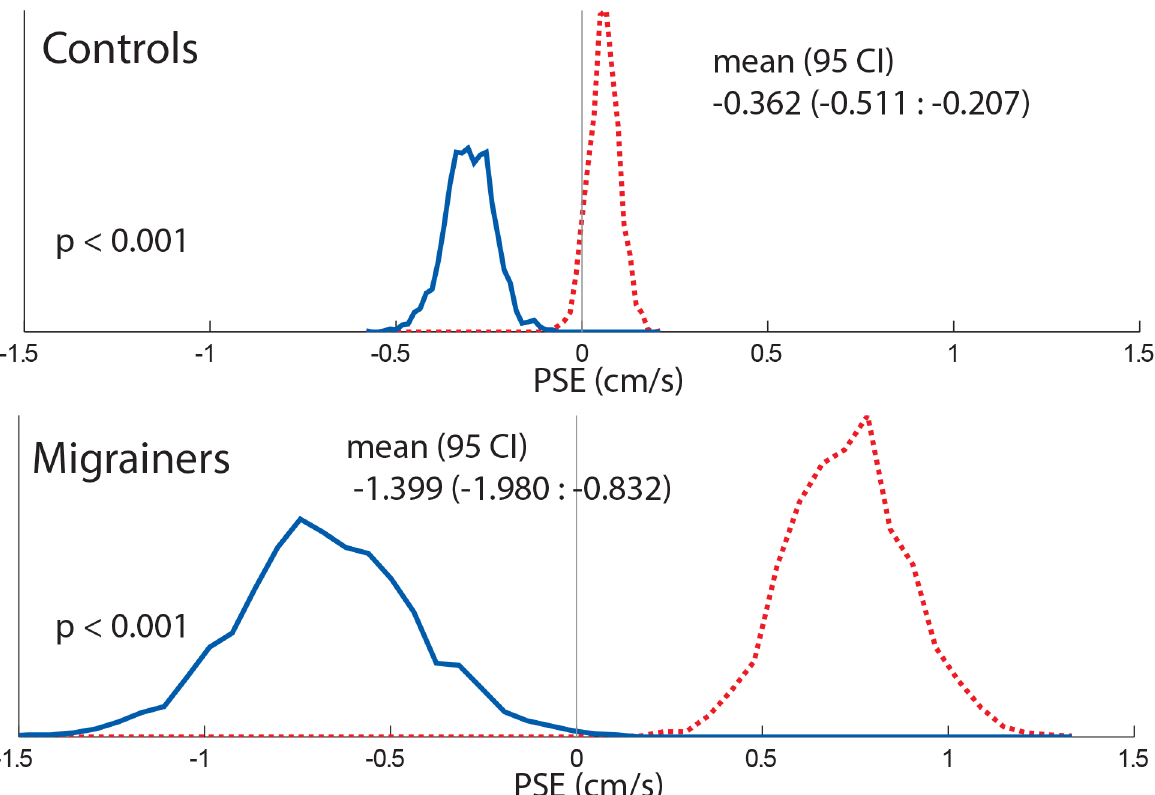
Fig 12. 8s Histogram comparing combined controls and migrainers response using a random resampling of responses. Responses from all subjects were included. Responses collected with looming VFM are represented with a dashed red line, receding VFM responses are represented with a solid blue